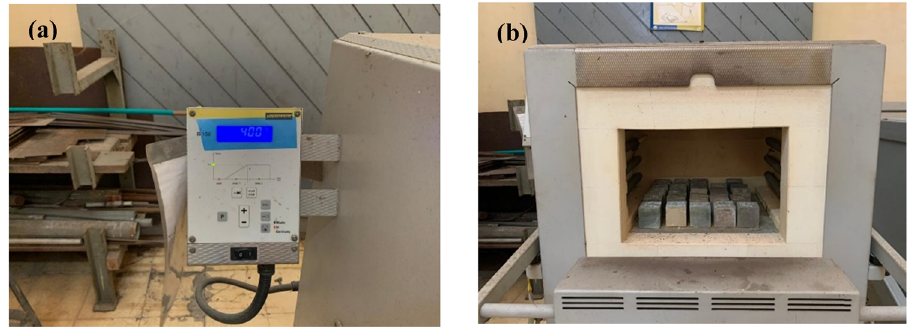
Figure 8: The exposure of the specimens in the laboratory furnace: ( a ) temperature set up and ( b ) specimens in the